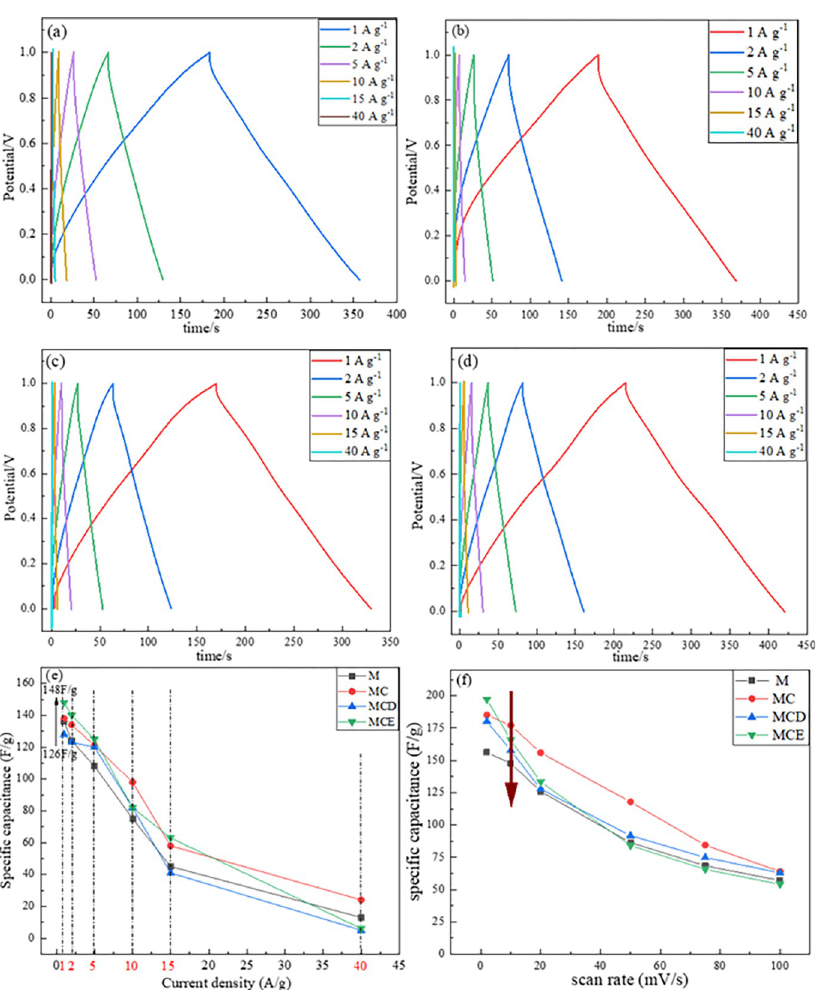
Fig 7. Charge/discharge curves of the electrodes at various current density: (a) product M (b) product MC (c) product MCD and (d) product MCE, (e) the specific capacitance at various current density, (f) specific capacitances of the fabricated M, MC, MCD and MCE at varied scan